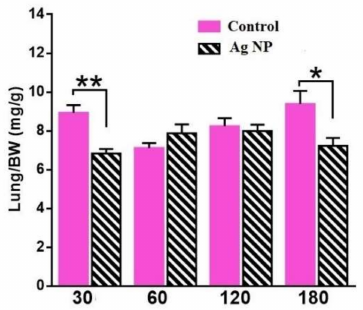
Figure 3. Weight of lungs per body weight for all groups. Reliable difference can be seen for the “30 days” and for the “180 days”.